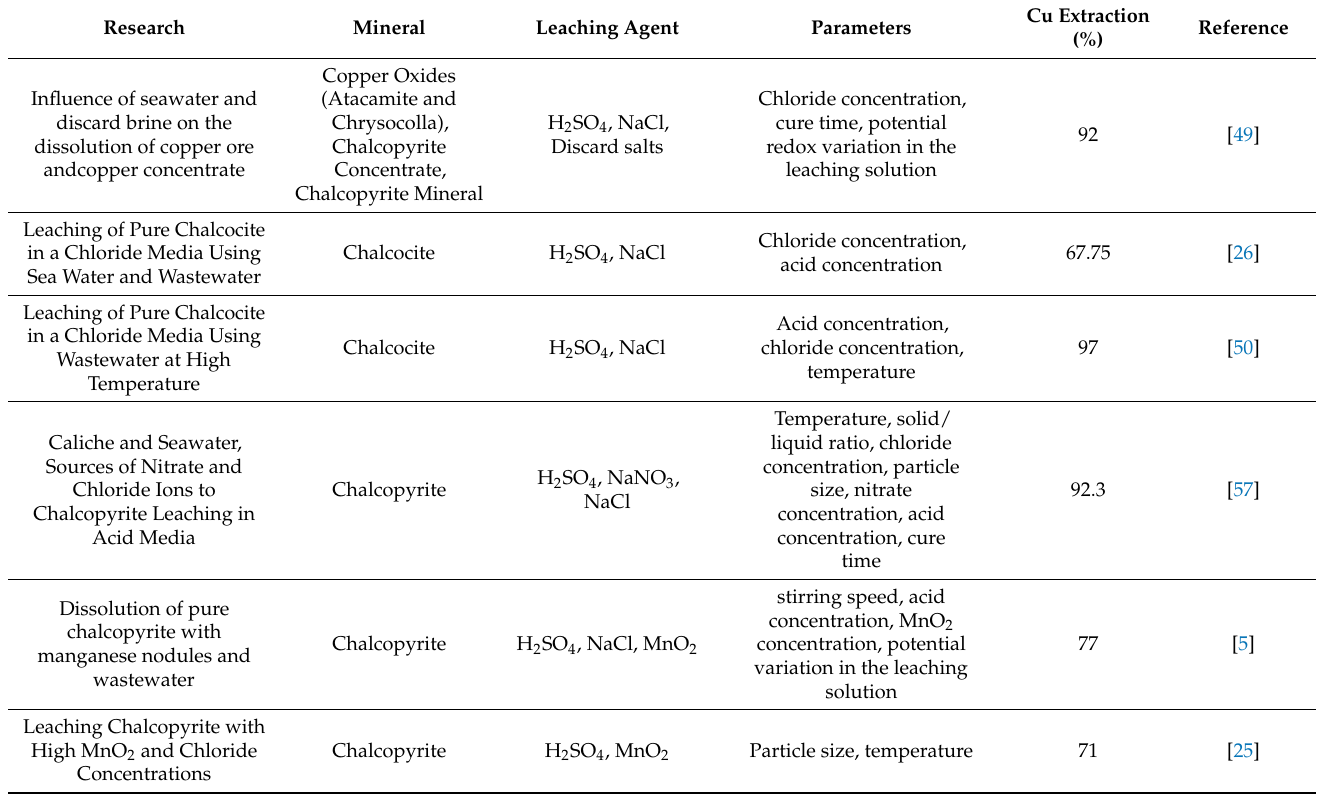
Table 6. Comparison between previous investigations for the dissolution of copper sulfide minerals in an acid medium using